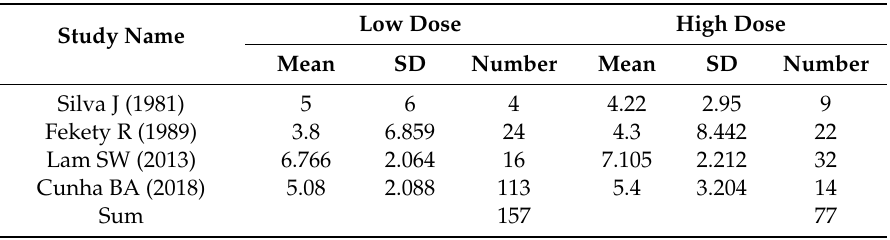
Table A1. Raw data regarding day of clinical